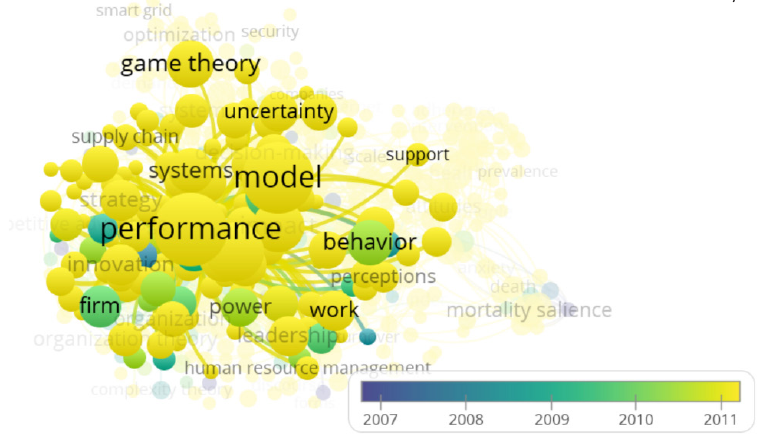
Figure 5. Keyword co-occurrence network over the years